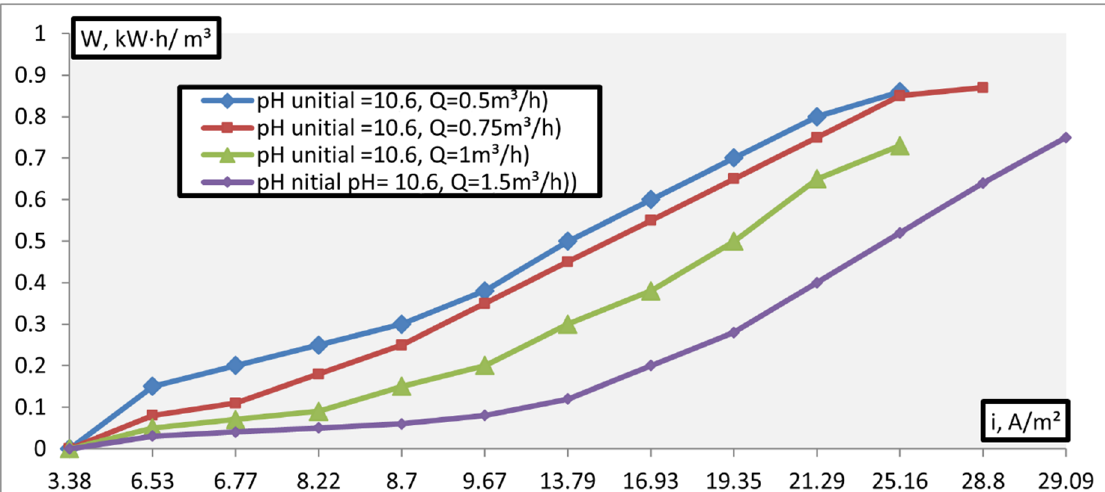
Figure 11. Dependence of the energy consumption of the process of adjusting acidic solutions on the current density.